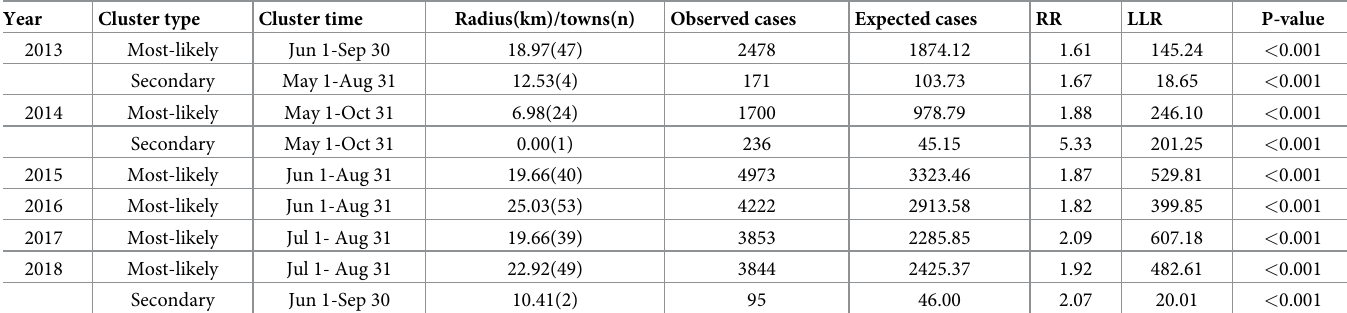
Table 4. Spatial-temporal clusters analysis of HFMD in Qingdao City, 2013–2018.